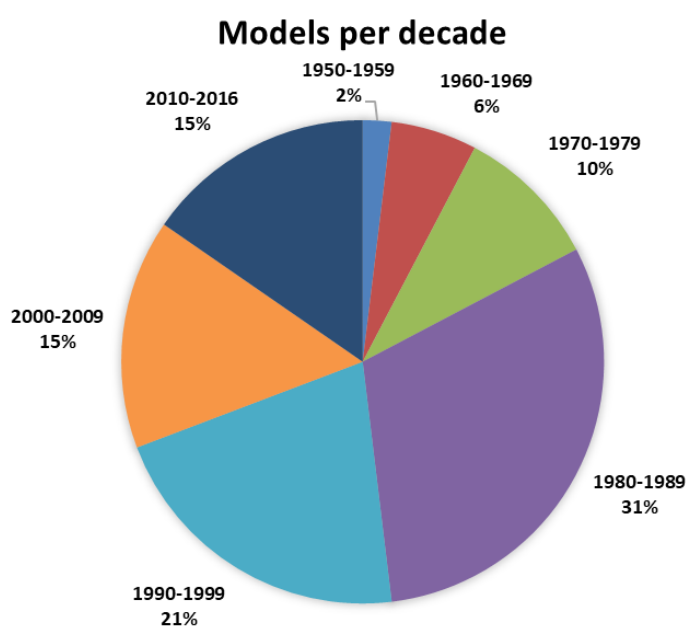
Figure 4. Publication date decades for rice blast prediction